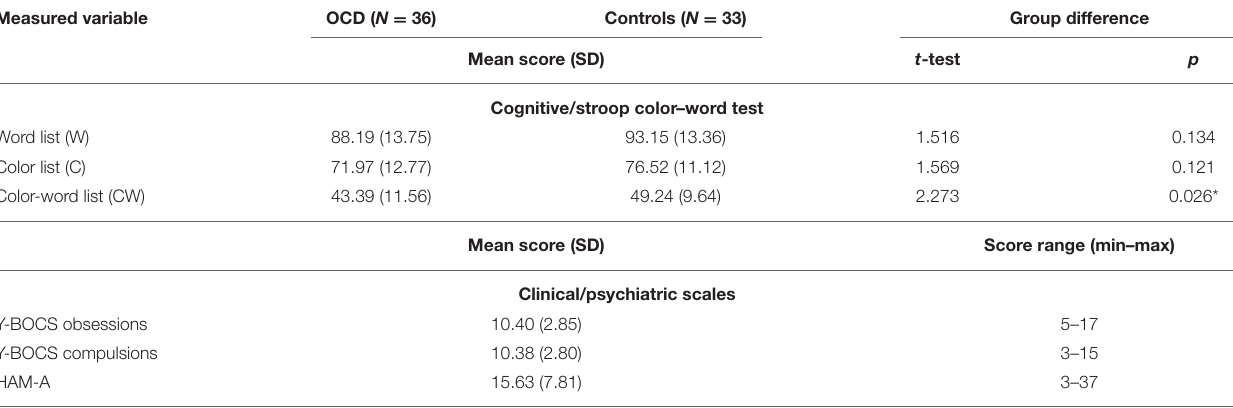
TABLE 2 | Cognitive and clinical measures.